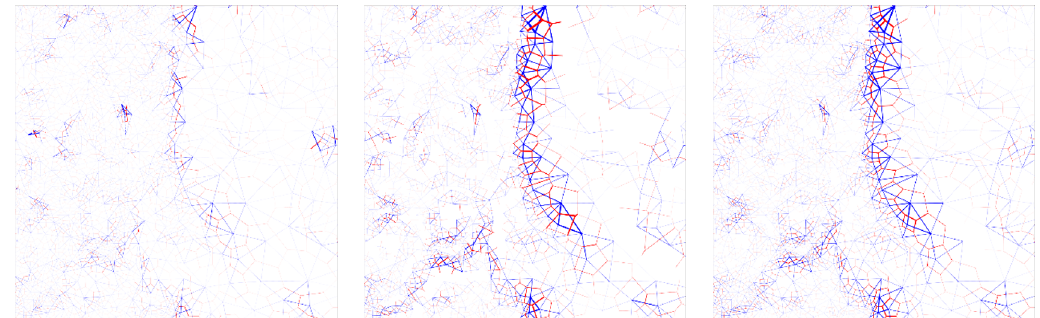
Figure 14 . Weighted network representations of the Voronoi tessellation (red lines) and the De- launay triangulation (blue lines). The line thickness is proportional to the weight, which is given by ˜ ~G ˜ ~G ~G i ~G i α · β (left panel), h i · h j (middle panel) and h weights are not